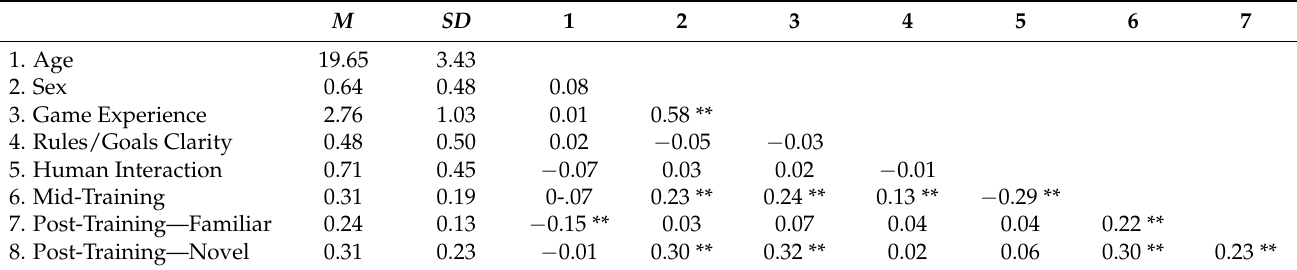
Table 1. Means, standard deviations, and correlations for study